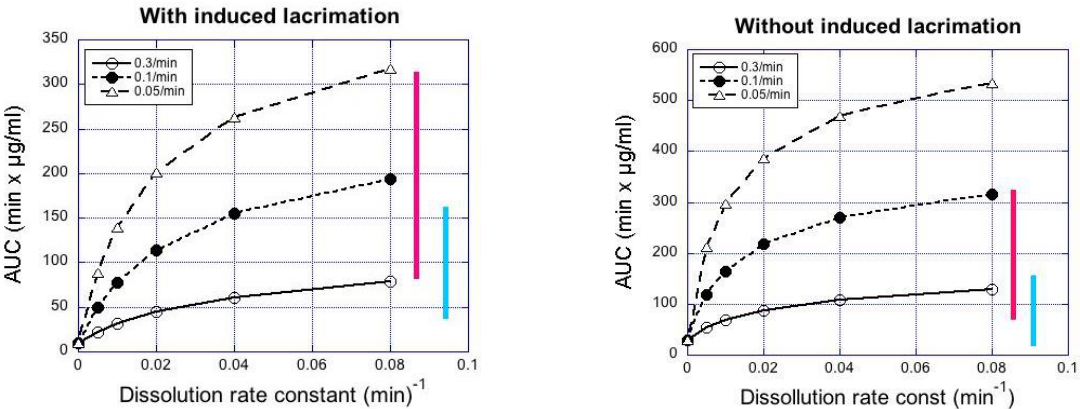
Figure 5. Simulated AUC 0–4h values in rabbit aqueous humor as a function of dissolution rate constant at sink conditions. The bars represent the range of experimental AUC 0–4h values in rabbits after instillation of large (blue) and small (red) suspension particles .